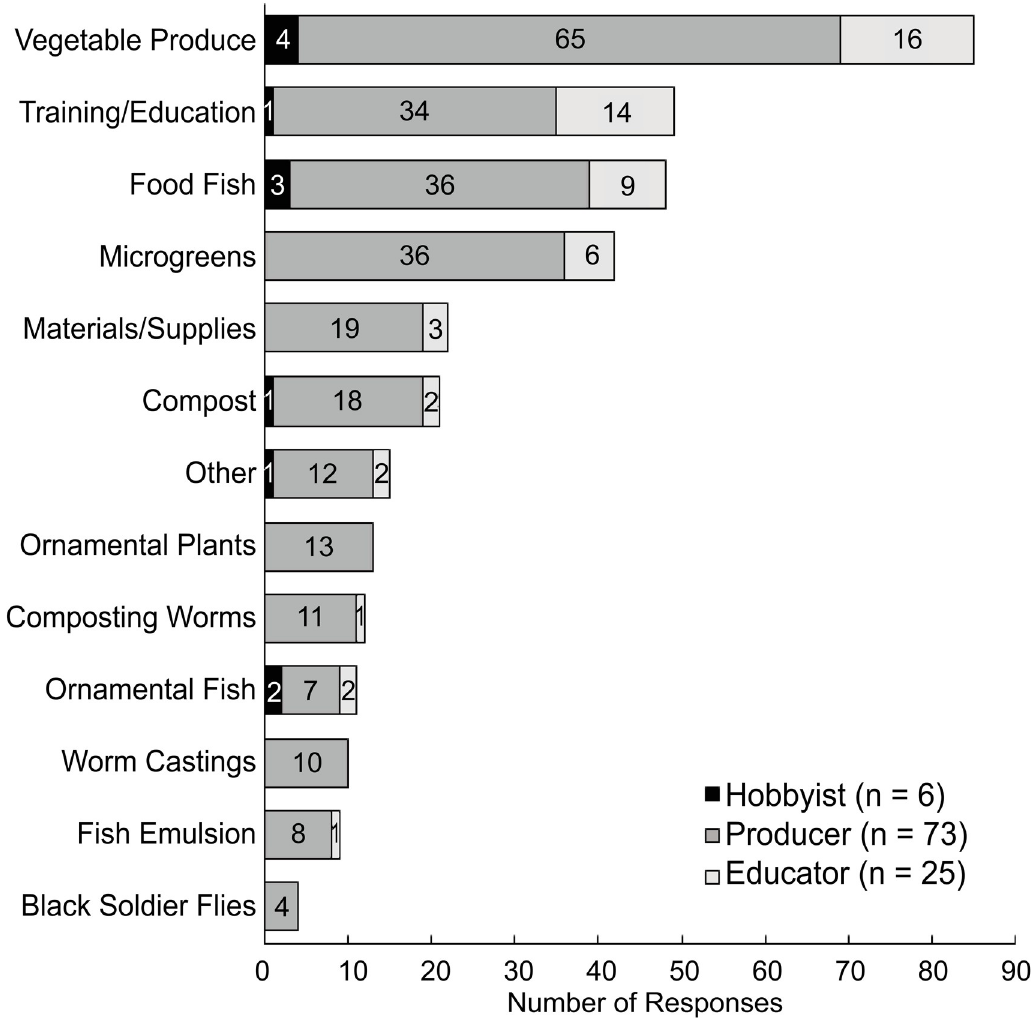
Fig 5. Frequency of product types sold by aquaponic hobbyists, producers, and educators. Numbers present within the bars represent the total number of selections made by each stakeholder